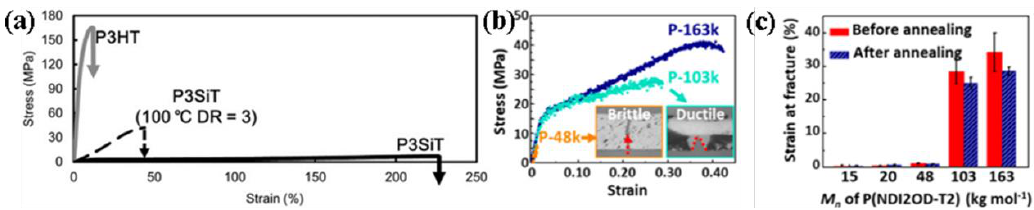
Figure 7. ( a ) Stress – strain curves of P3SiT and P3HT under three tensile cycles at 100 °C. ( b ) stress – strain curves and ( c ) elastic moduli of polymers (p (NDI2OD-T2)) with different molecular weights.